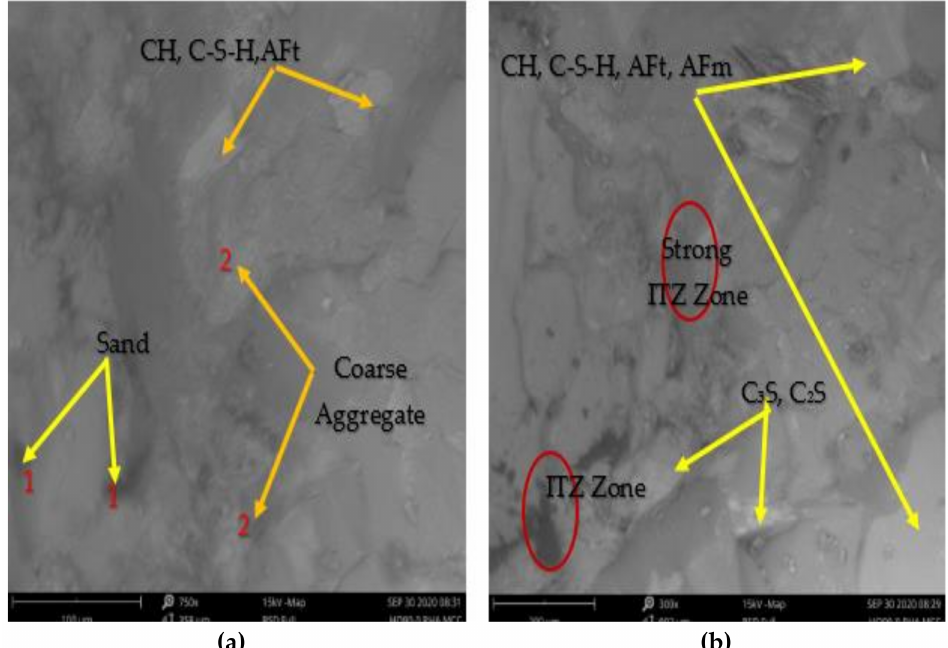
Figure 13. ( a , b ) SEM images of control HPC at 90 days.